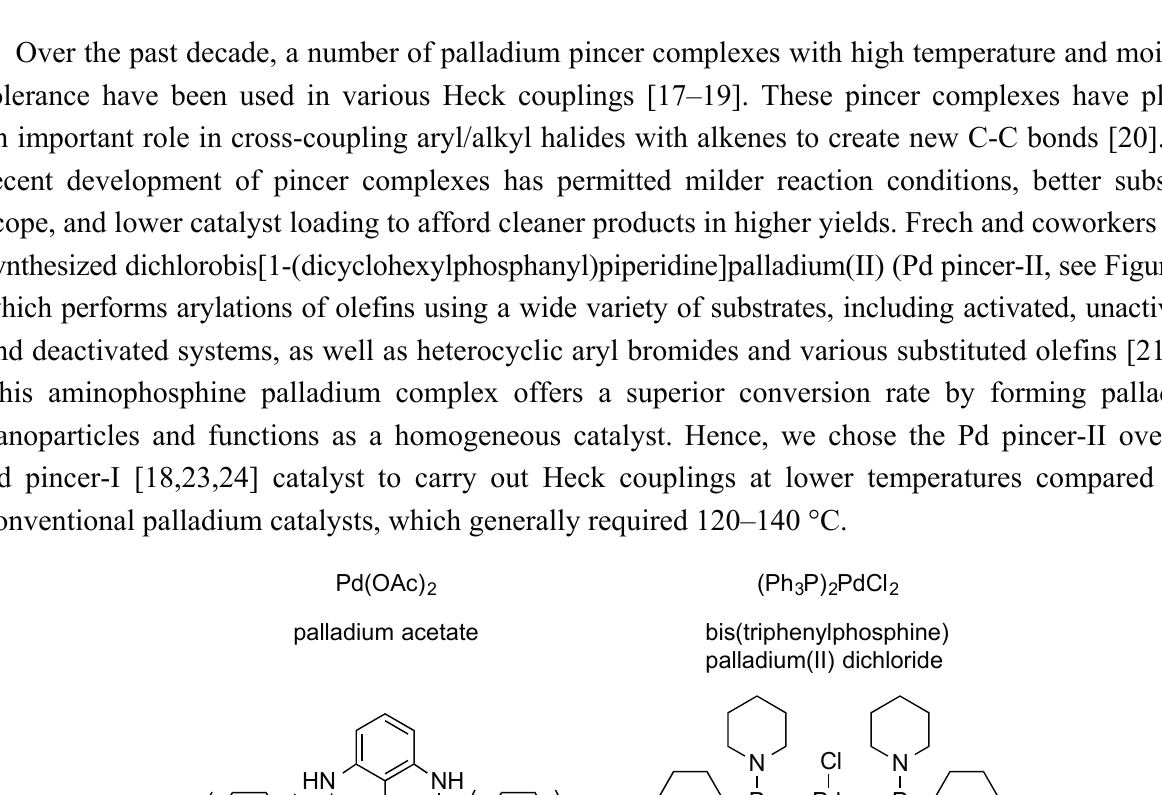
Figure 1. Modification of DAP inhibitors.